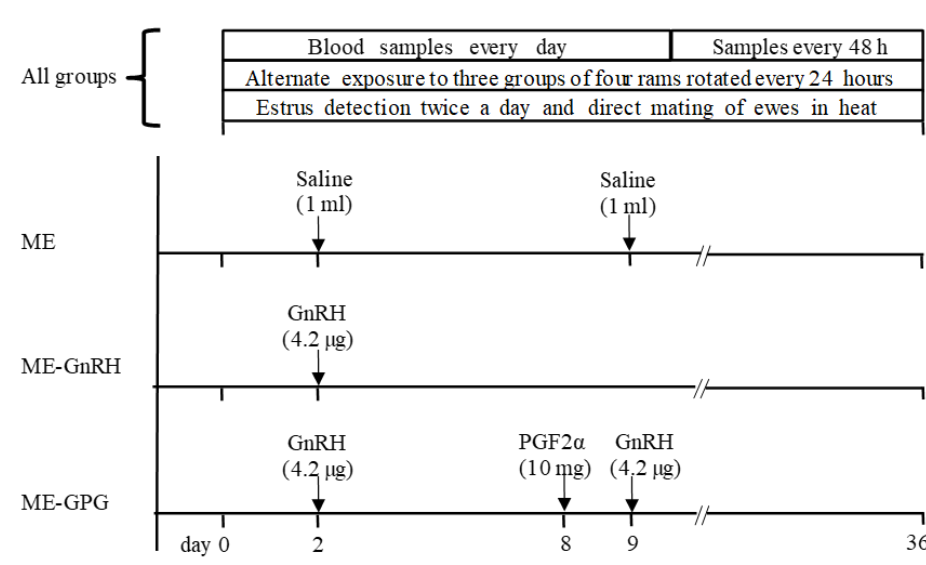
Figure 2. Schematic diagram of the schedule of activities and treatments in experiment